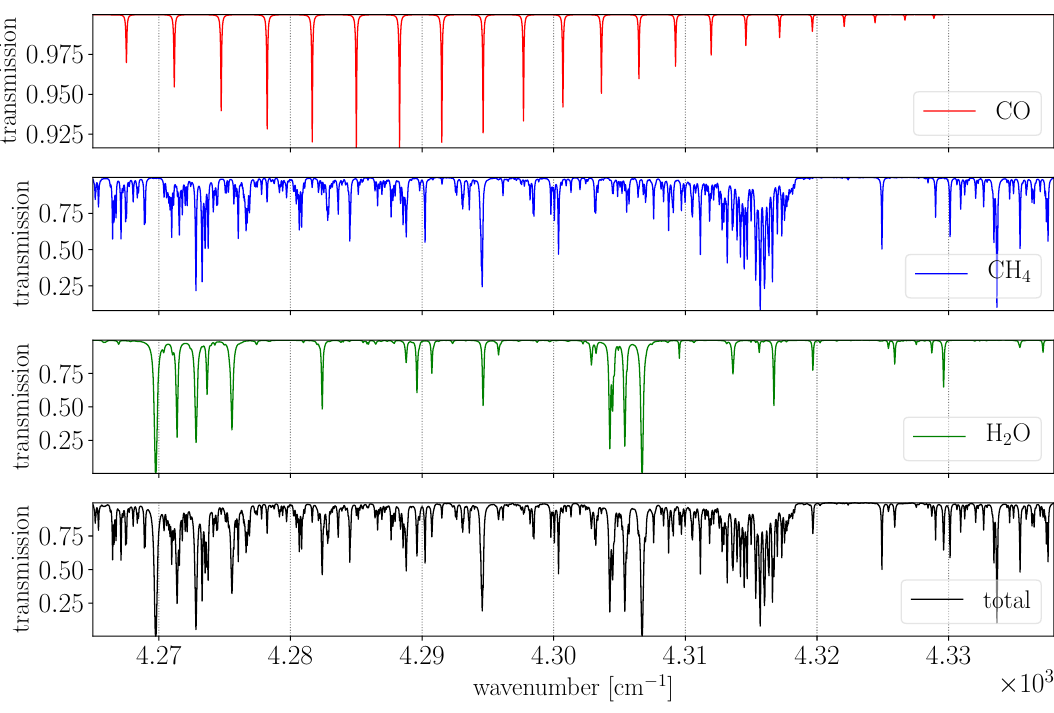
Figure 1. Spectral transmittance of CO, CH 4 and H 2 O (upper three panels) according to Beer-Lambert’s law in spectral range of TROPOMI’s band 7 for a single path through the US-Standard atmosphere using Scientific Exploitation of Operational Missions (SEOM) line data. The total transmission for the three molecules is depicted in the lower panel. The Python tool Py4CAtS (Python for Computational ATmospheric Spectroscopy [30]) was used to calculate the absorption cross sections of the individual molecules. Note that CO is only responsible for 1% of the total optical thickness τ in ≈ that spectral